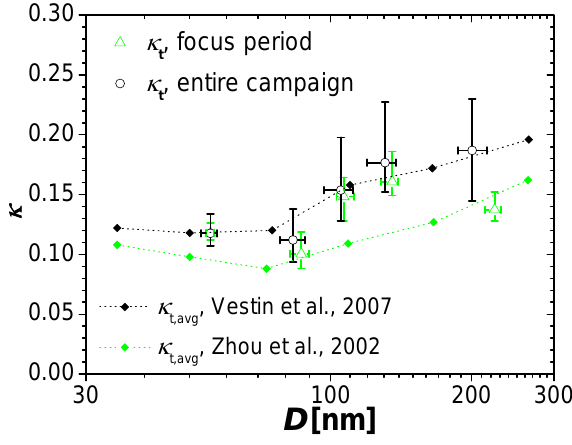
Fig. 5. Effective hygroscopicity parameters for the overall population of aerosol particles observed in pristine Amazonian rainforest air during AMAZE-08 and earlier campaigns during the wet season (CLAIRE 1998, Zhou et al., 2002; LBA-SMOCC 2002, Vestin et al., 2007). κ t was determined by 2-parameter CDF fits to the size-resolved CCN efficiency spectra measured in this study (me- dian values for the entire campaign and for the focus period with error bars extending to upper and lower quartiles). κ t , avg was cal- culated from the HTDMA measurement results reported by Zhou et al., 2002 and Vestin et al., 2007 (campaign average values with connecting lines, Table